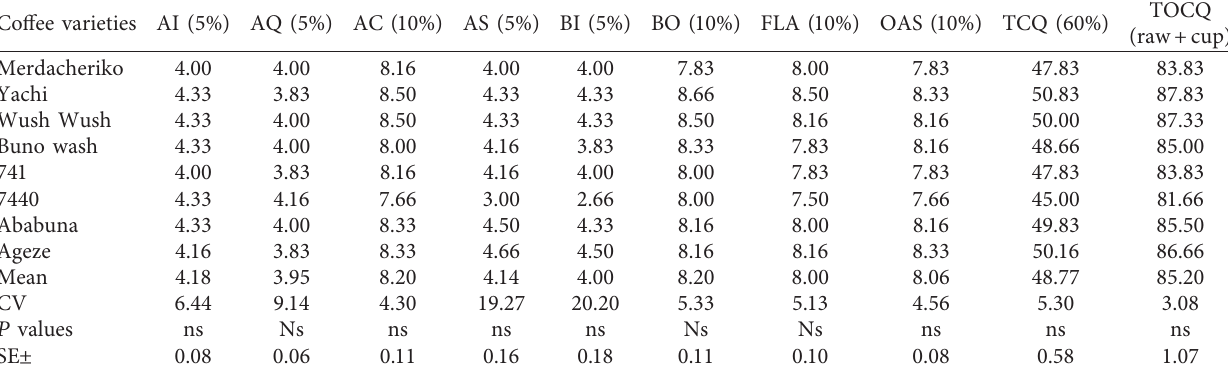
Table 5: Bean cup quality of coffee varieties grown in AARC during 2018 main cropping